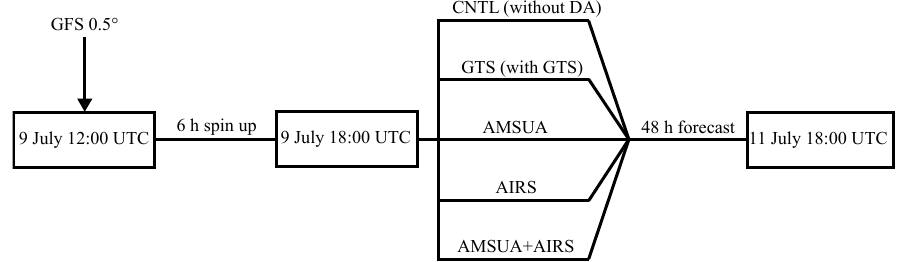
Figure 3. Flow chart of the experiments. GFS: Global Forecast System initial and boundary conditions, CNTL: control experiment, GTS: Global Telecommunications System, AMSU-A: Advanced Microwave Sounding Unit-A, AIRS: Atmospheric Infrared